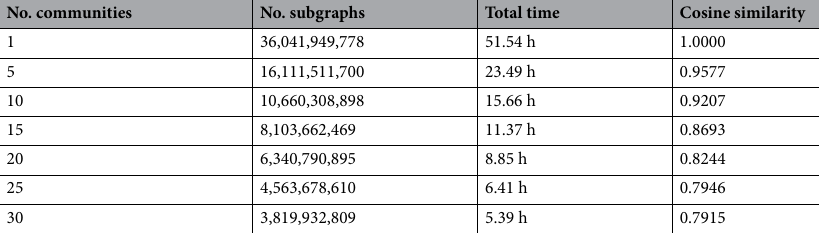
Table 3. Divide-and-conquer subgraph enumeration. A divide-and-conquer approach can significantly decrease the total amount of computation time required when enumerating very large connectomes, although at the expense of total subgraphs enumerated. These results come from k = 4 on the Drosophila dataset.